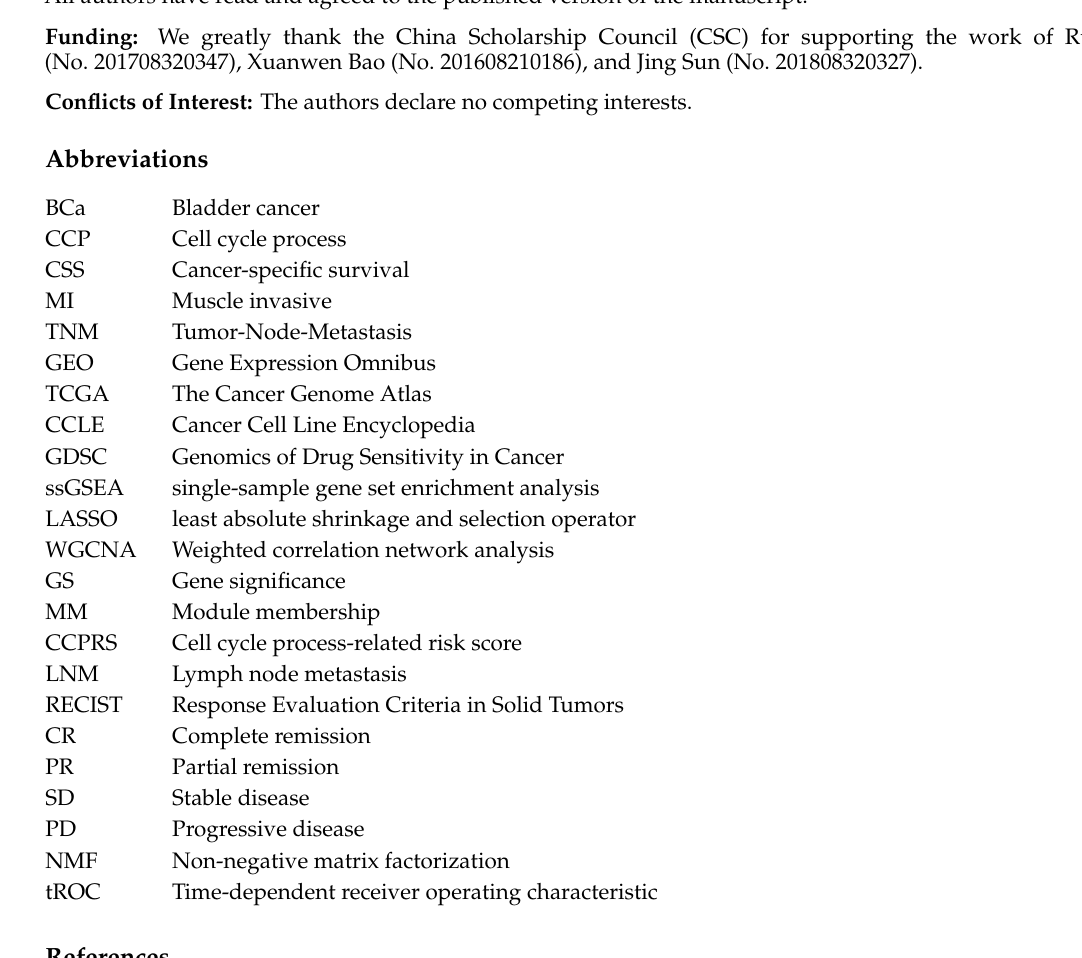
Figure S1. A detailed screening diagram to establish a robust gene signature for CSS; Figure S2. Sample clustering showed one outlier was detected and excluded in WGCNA; Figure S3. A power of β = 9 was chosen as the